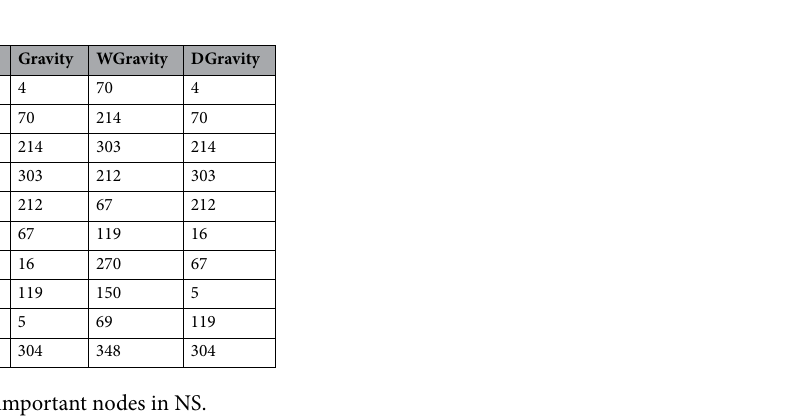
Table 3. The top 10 important nodes in NS.